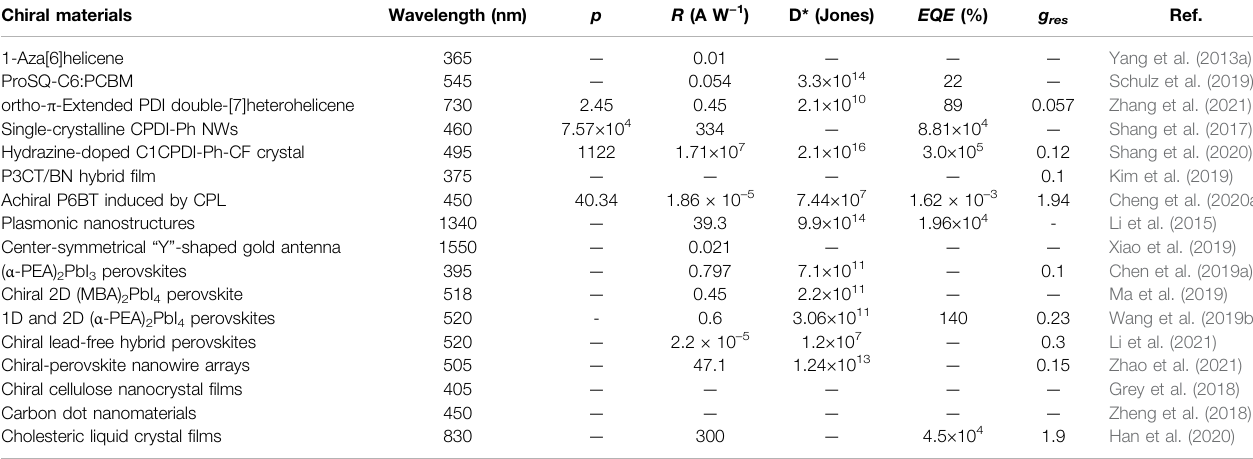
TABLE 1 | Comparison of the key parameters of the presented CPL photodetectors. Chiral